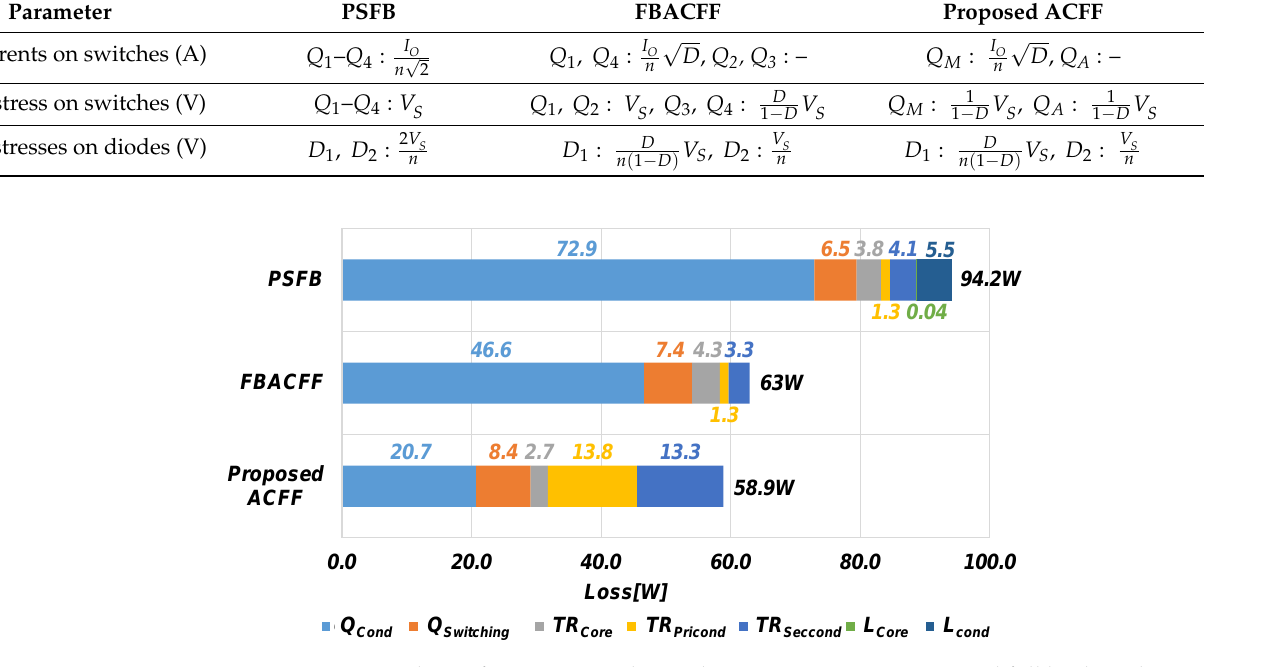
Figure 12. Loss analysis of primary switches and magnetics at 270 V input and full load condi- tions.